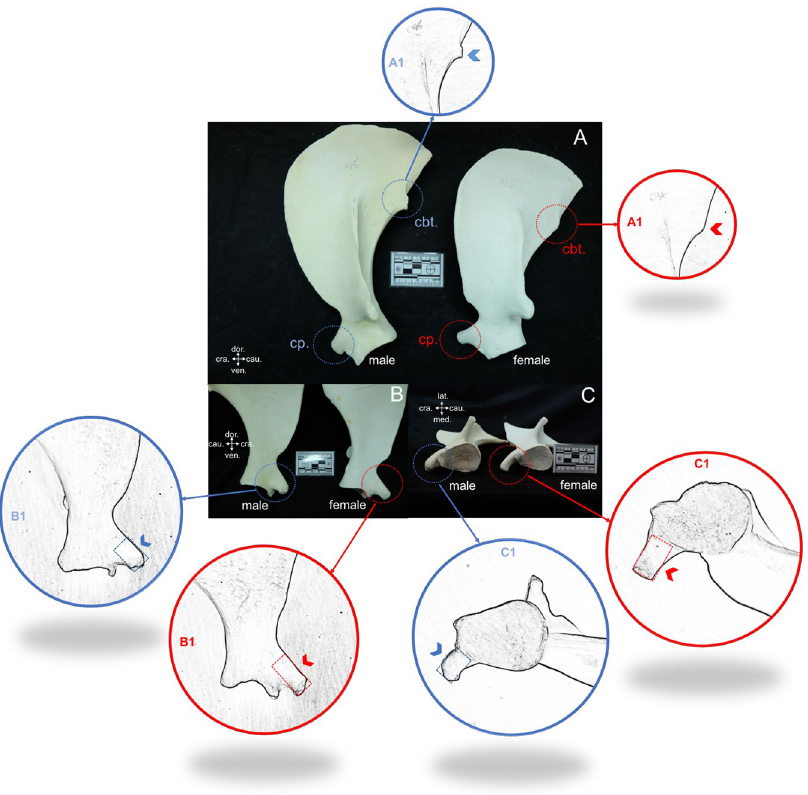
Figure 6. Lateral view ( A ), medial view ( B ) and ventral view ( C ) comparing scapulas of male (DU058) and female (DU129) dugongs revealed two significant hallmarks that could be used for sex identification: caudal border tuberosity (cbt.) and coracoid process (cp.) ( A ). In males, the scapula presented a caudal border tuberosity (A1), while in females this was not present (A2). The shape of the coracoid process in females is smaller and longer (B1,C1), while in males it is shorter and thicker (B2,C2). (cra. = cranial, cau. = caudal, dor. = dorsal, lat. = lateral, med. = median, ven. =